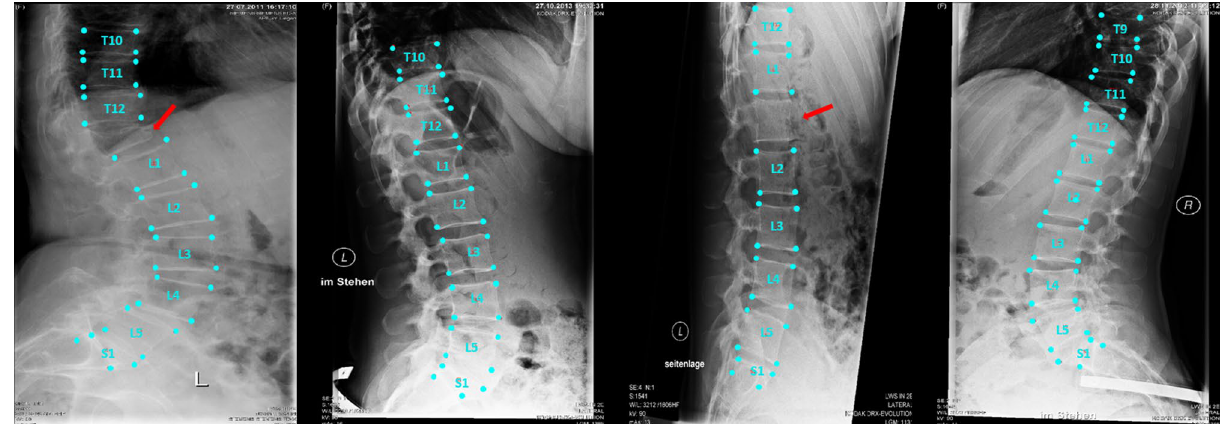
Figure 3. Four random images from the test set. The red arrows indicate the vertebrae missed by the model. In the first image, a fractured vertebra was missed. In the third image from the left the step I model (vertebra identification) missed the T11 vertebra and the error was propagated to step II.